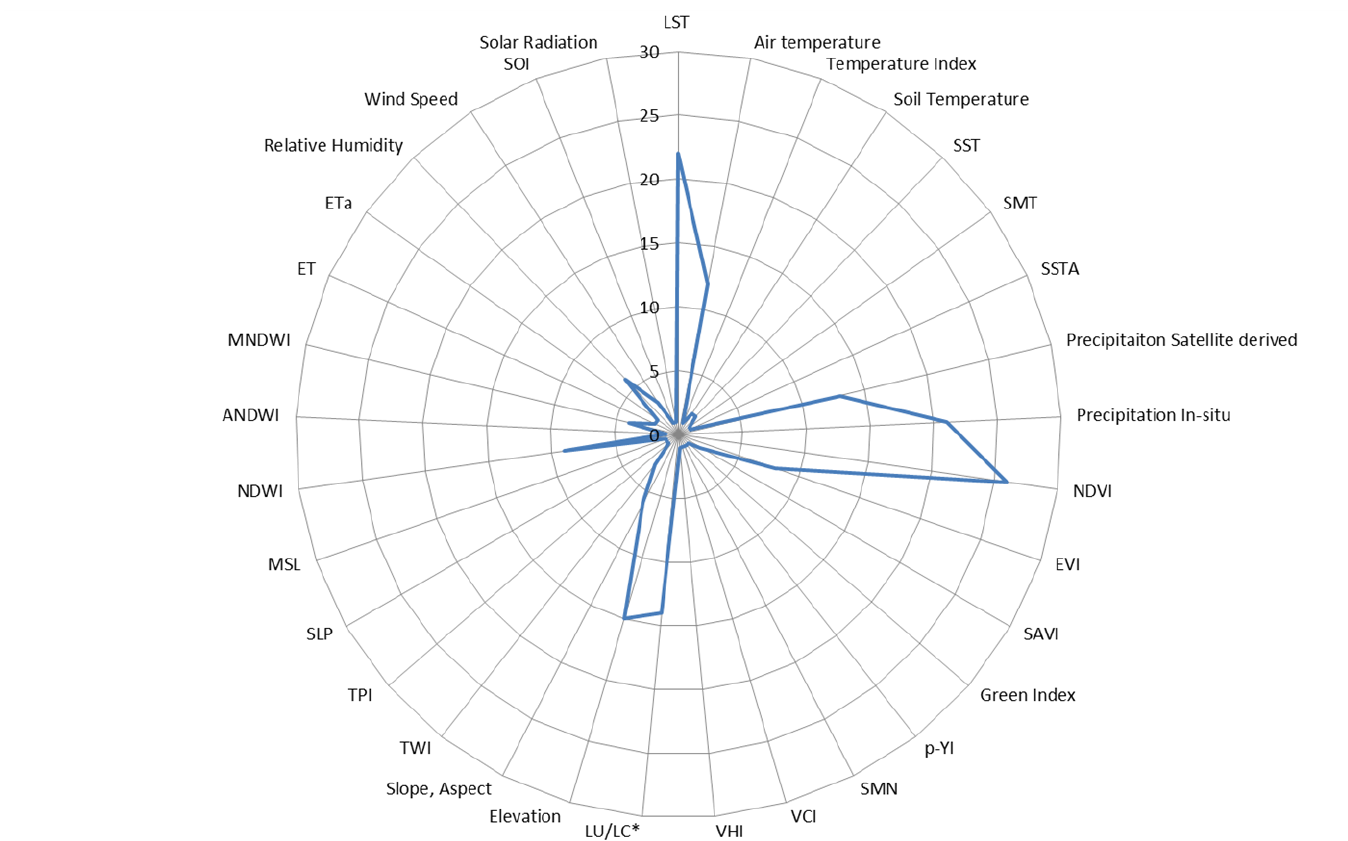
Figure 4. Overview of studies that utilized EO derived environmental/climatic variables: